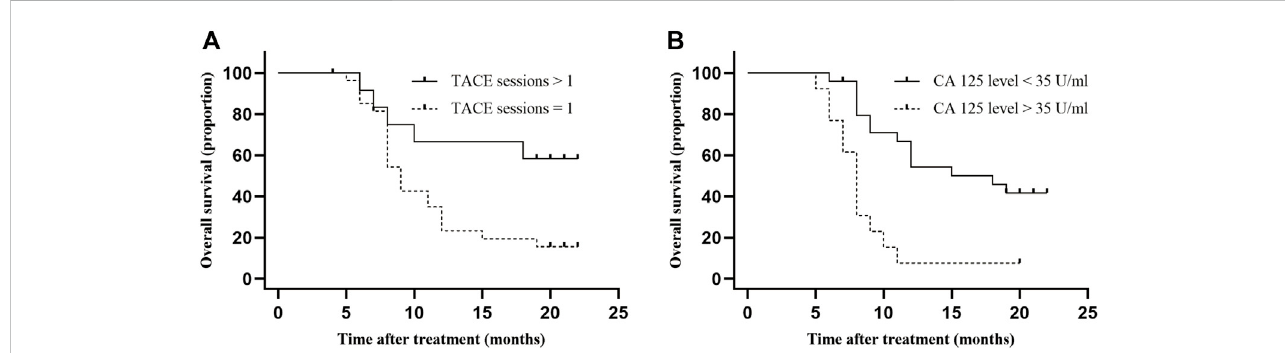
FIGURE 5 Comparison of OS in subgroup analysis. Independent predictive factors of OS were selected in subgroup analysis to further evaluate their in fl uence on patients ’ survival. (A) MedianOSwas19.5 monthsinTACEsessions > 1groupand9.0 months(95%CI:5.9 – 10.1)inTACEsessions=1group, p -value=.017; (B) Median OS was 18.0 months (95% CI: 5.8 – 12.2) in low CA 125 level group and 8.0 months (95% CI: .0 – 25.9) in high CA 125 level group, p -value = .001.